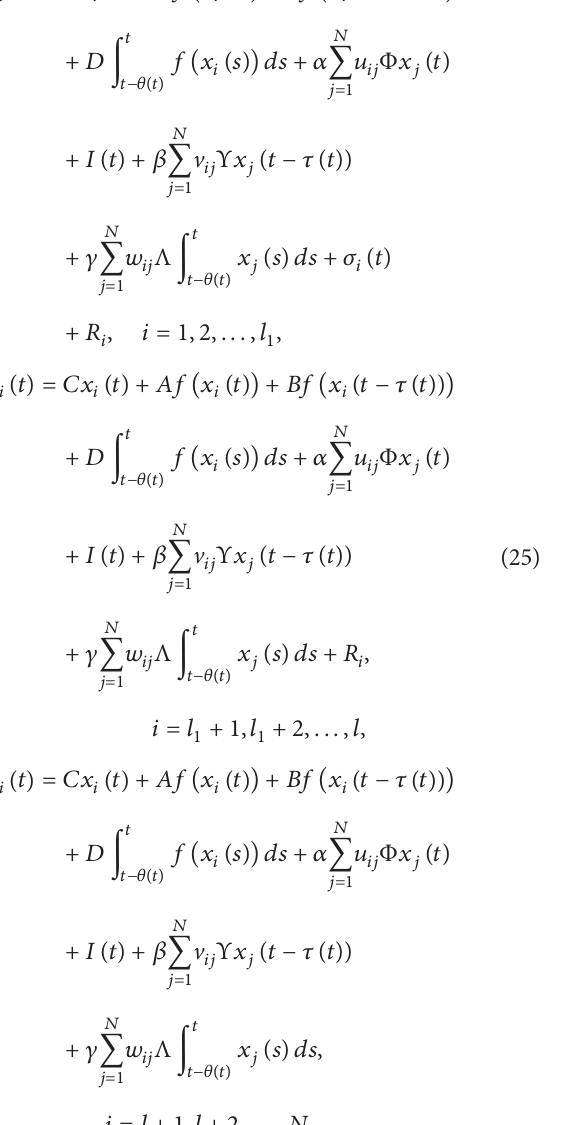
Figure 1: Chaotic trajectory of